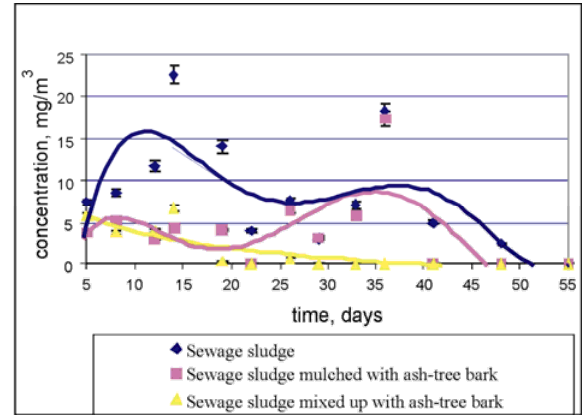
Fig. 16. VOC emissions during composting sewage sludge with ash-tree bark